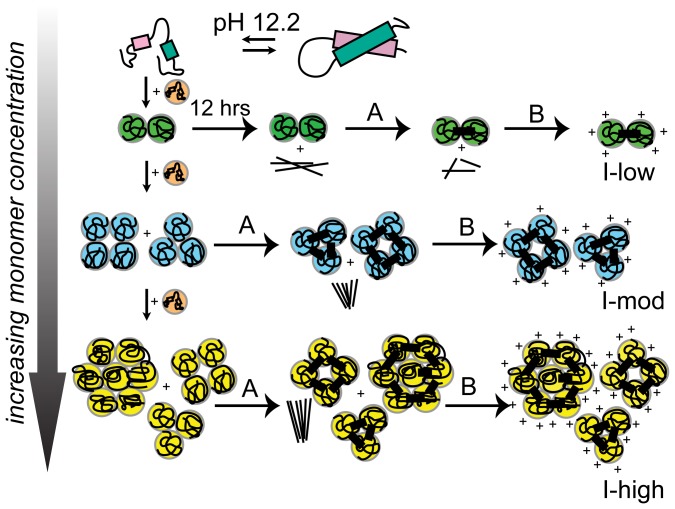
Schematic model for isodesmic aggregation of HEWL at pH 12.2.Exposure to pH(∼0.3 µM), moderate (3—10 µM) and high (120 µM) equilibrium aggregation intermediates or protein nanoparticles of increasing average size were obtained. Step A highlights formation of intermolecular disulphide bonds (thick bars) after 100 hours in pH 12.2. Step B yields stable polycationic HEWL nanostructures after dilution into 100 mM pH 7 sodium phosphate buffer after 134 hours in pH 12.2. Thin line clusters indicate amyloid fibrils formed on pathway.